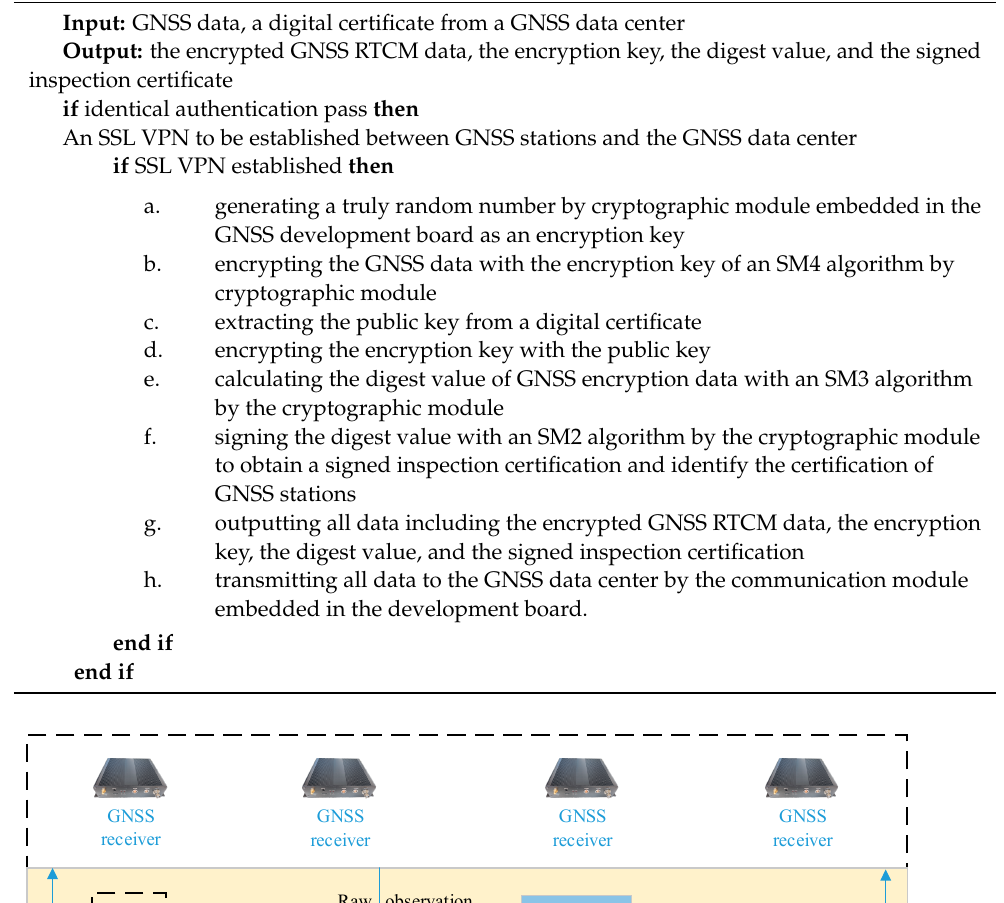
Algorithm 1 : Encryption steps of GNSS data transmission